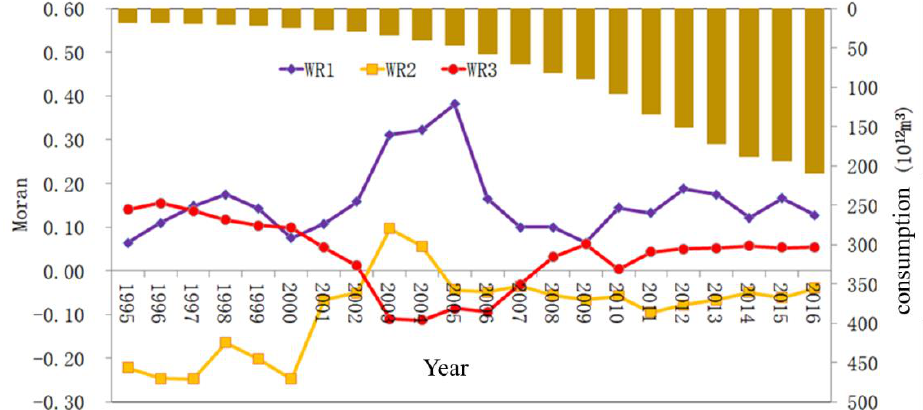
Figure 2. Global Moran ’I Index of First-, Second- and Third-Order Adjacent Matrices.